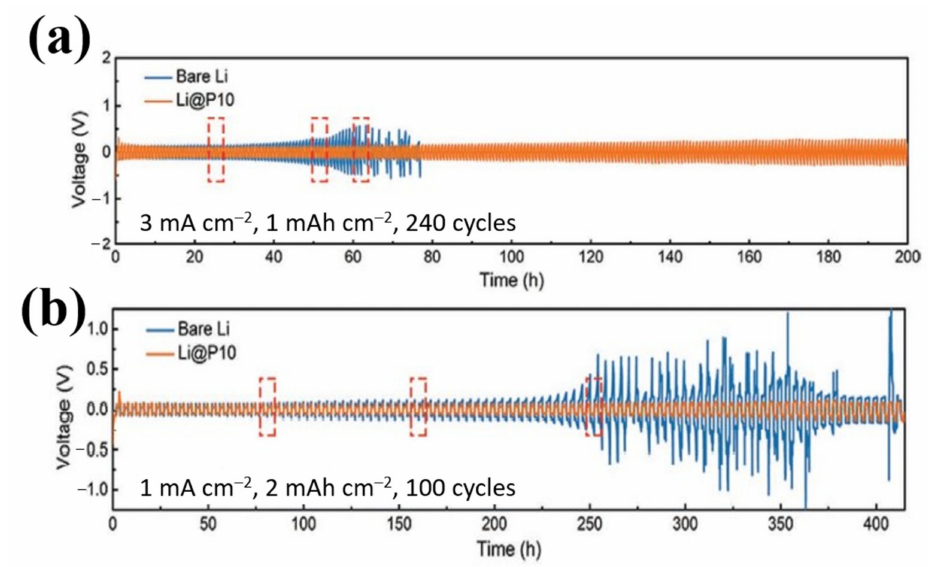
Figure 11. Cycling performance for the symmetric cells using bare Li and polyurea coated Li at ( a ) 3 mA cm − 2 and ( b ) 1 mA cm − 2 [116]. Reproduced with permission [116]. Copyright 2019,